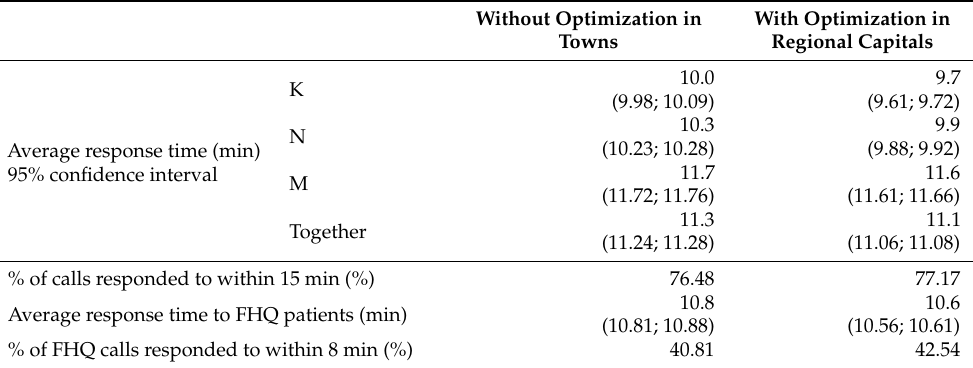
Without Optimization in Towns